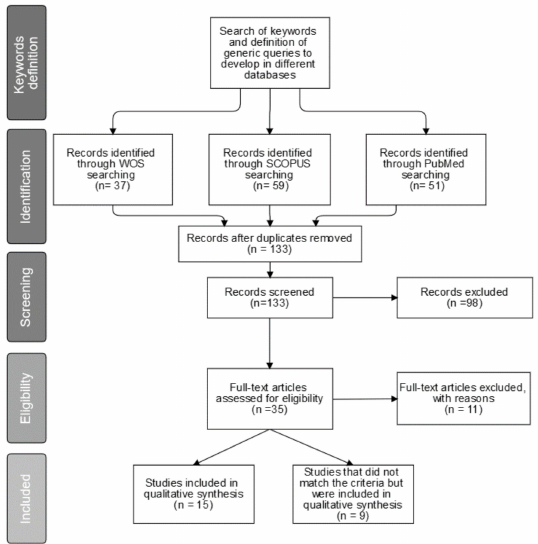
Figure 1. Study selection according to the Preferred Reporting Items for Systematic Reviews and Meta-Analyses (PRISMA) statement.